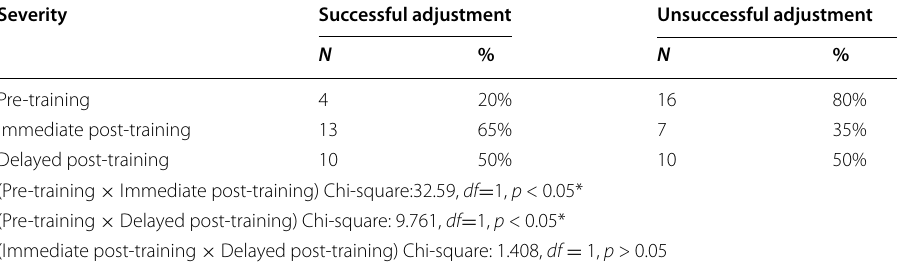
Table 8 Effectiveness of training program and feedback provision on raters’ severity measures Severity Successful adjustment